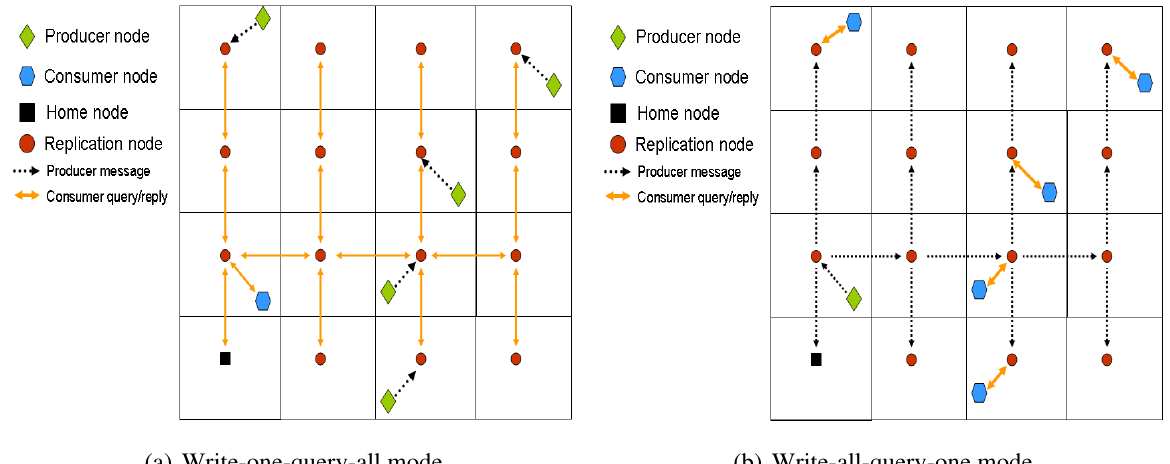
Figure 4. Multi-replication grid in ToW with combing